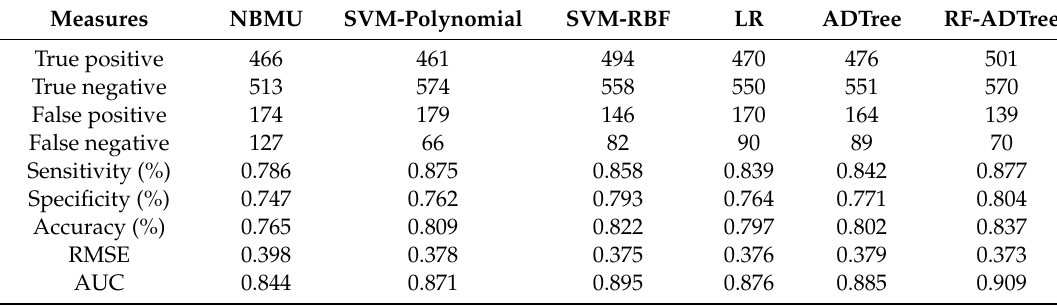
Table 3. Model performances in the training dataset for the new hybrid “RF-ADTree” model and other benchmark models.